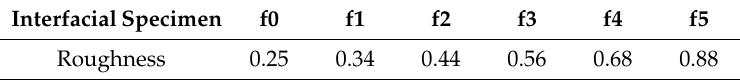
Table 3. Quantized values for roughness of six types of interfaces.